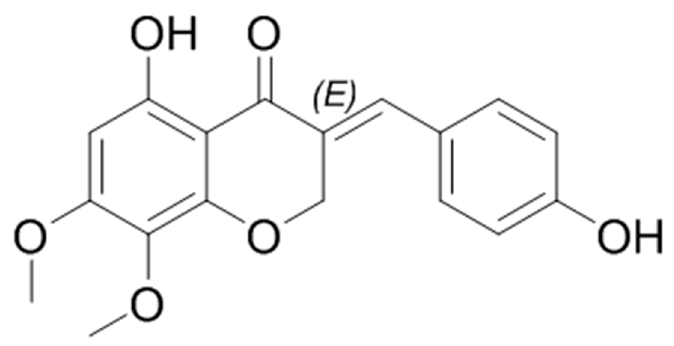
Figure 1. The chemical structure of 7- O -methylpunctatin (MP).